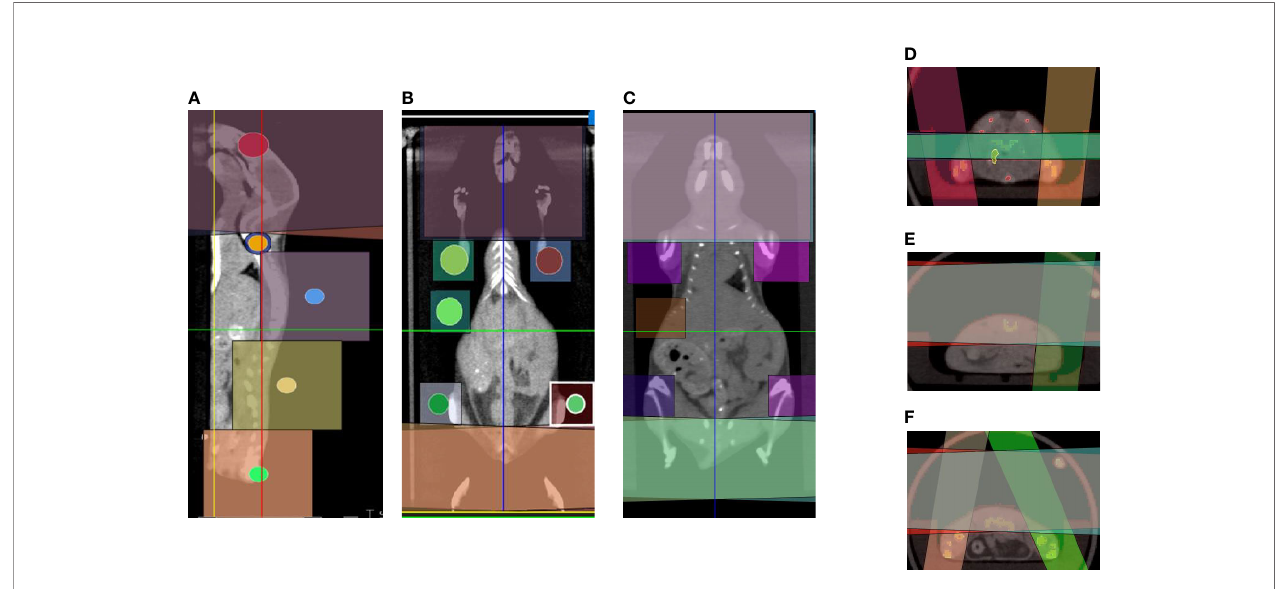
FIGURE 1 | Common beam arrangements of 3D-TMI treatment. Beam arrangement for parallel opposed beams in (A) sagittal view. (B, C) Coronal views demonstrating different body levels. (D – F) Axial view in the thoracic, abdominal, and pelvic level showing beams